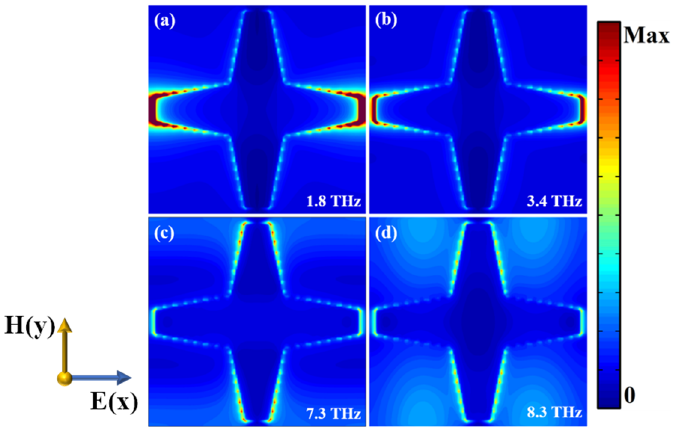
Figure 4. Electric field distribution of the top VO 2 patch in the xoy plane at ( a ) 1.8 THz, ( b ) 3.4 THz, ( c ) 7.3 THz, and ( d ) 8.3 THz.